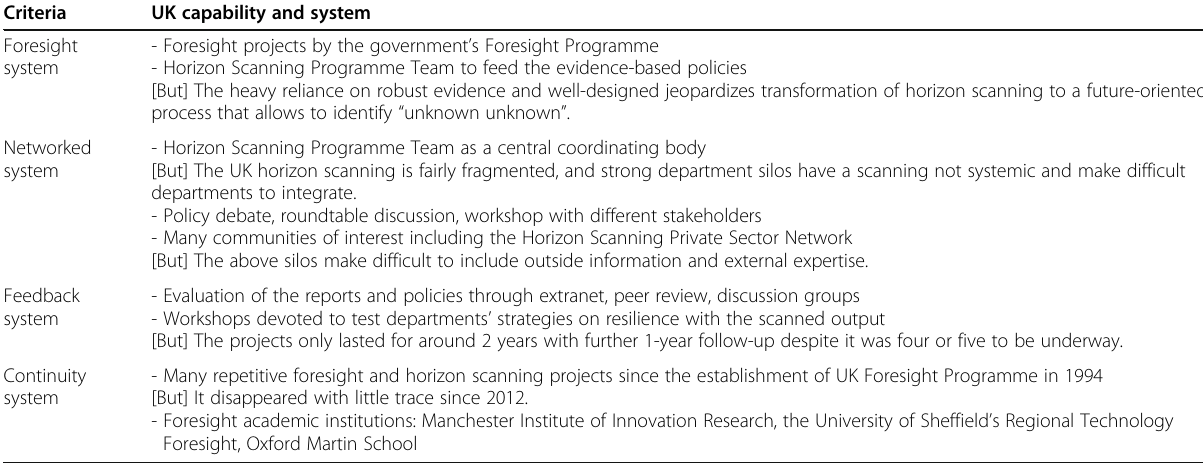
Table 4 The UK ’ s AG level under the new framework